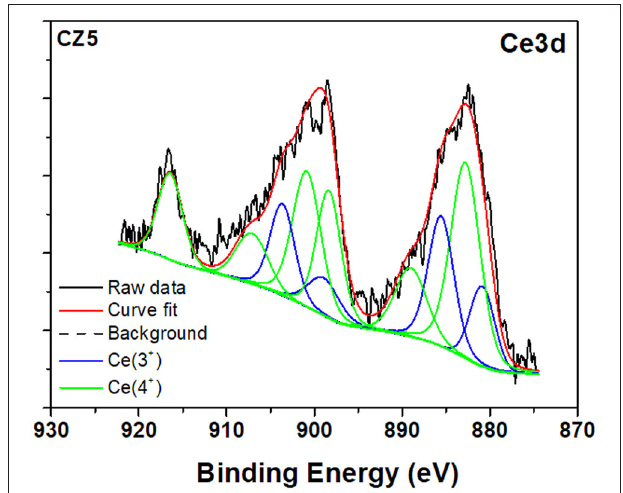
FIGURE 3 | XPS high-resolution spectrum on Ce3d for 5% Ce-doped